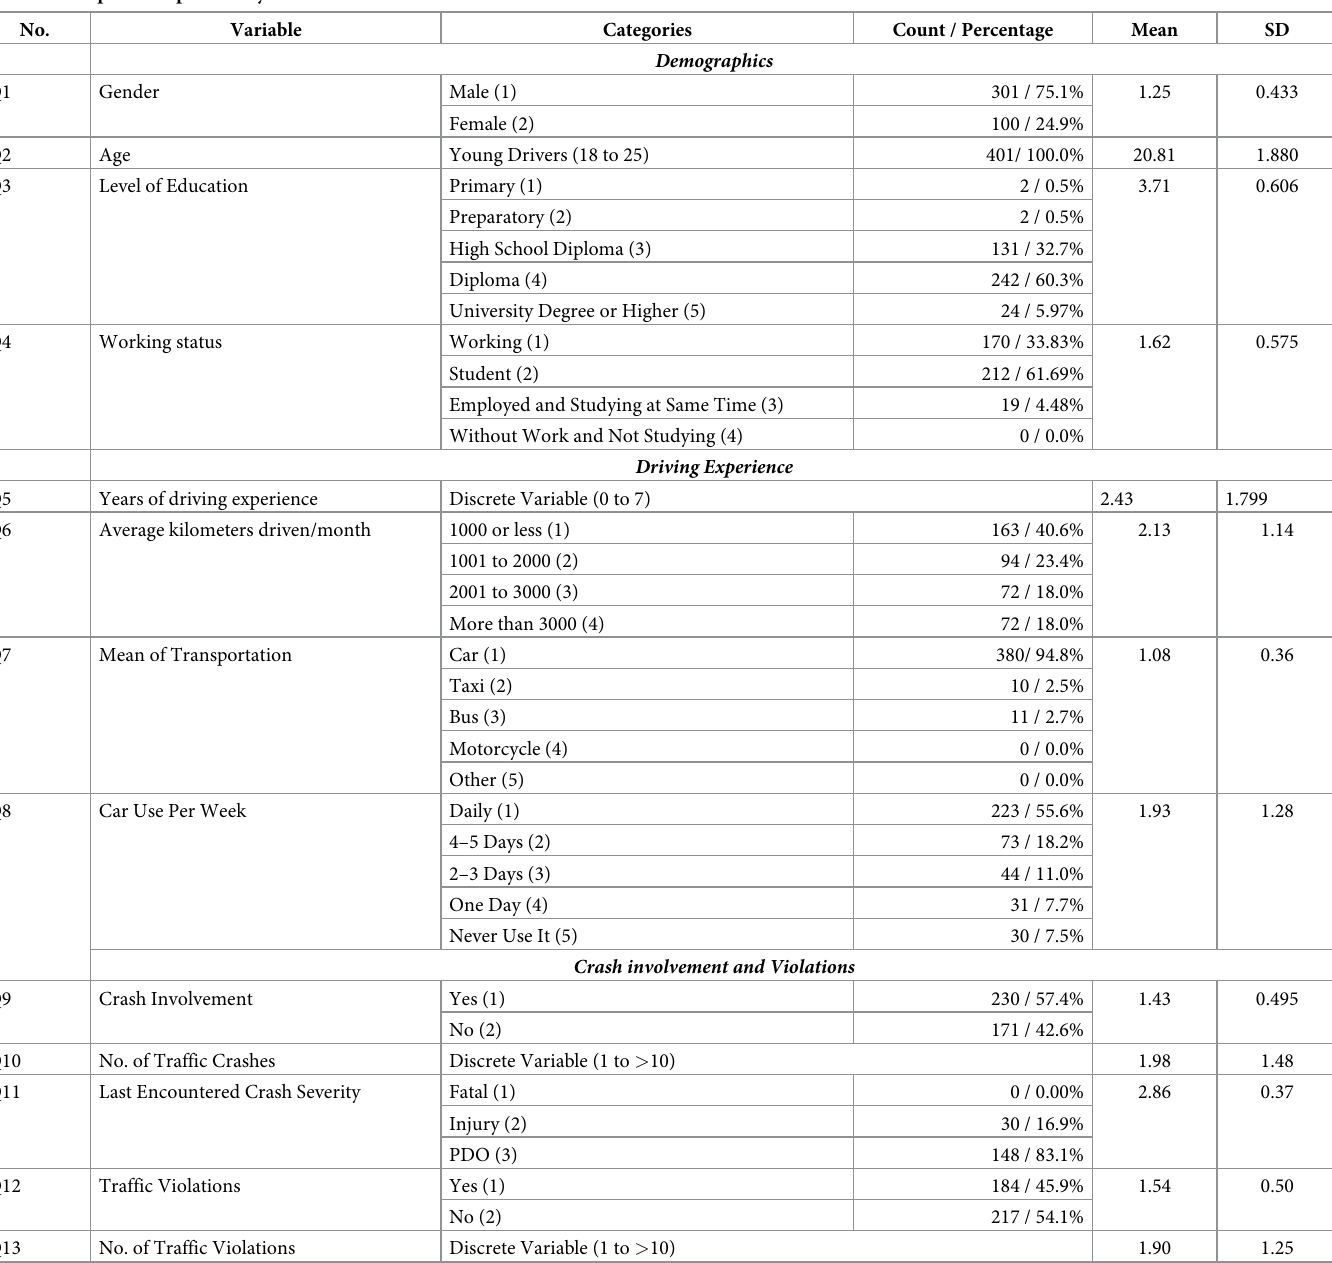
Table 1. Sample descriptive